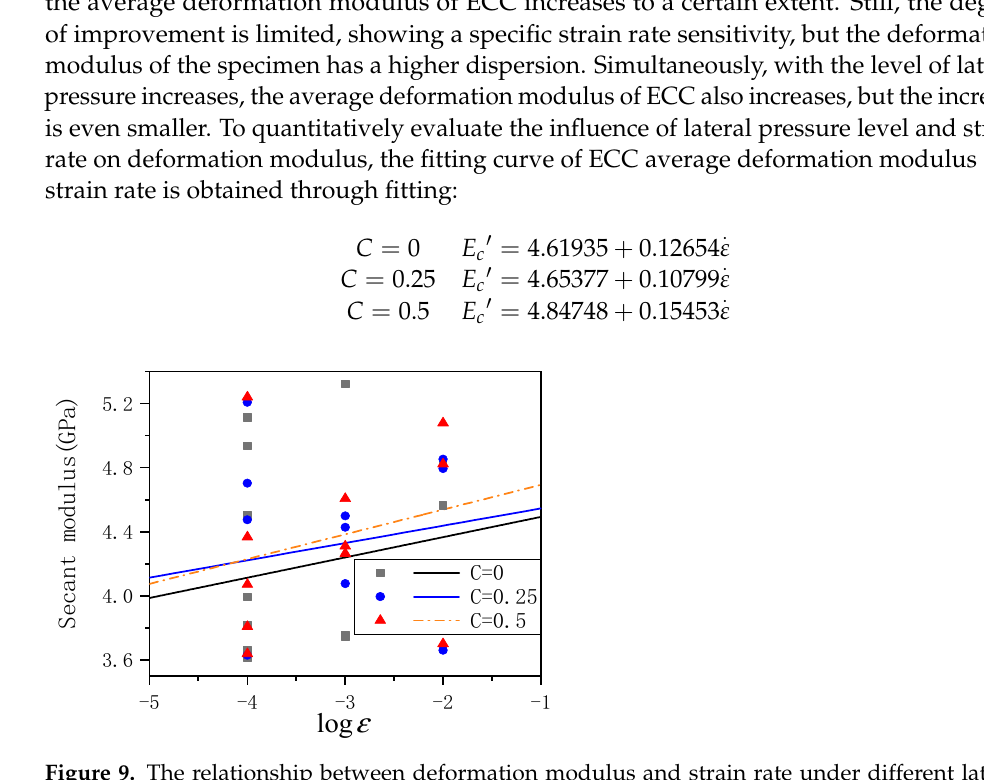
Figure 9. The relationship between deformation modulus and strain rate under different lateral pressure levels.